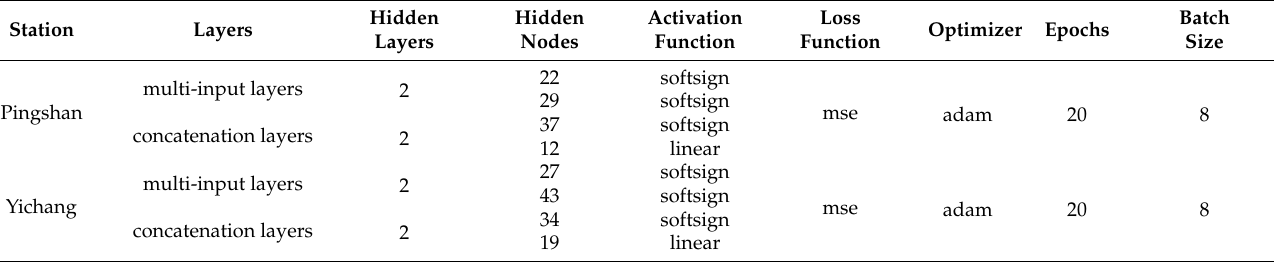
Table 2. Summary of the parameter configuration of forecasting